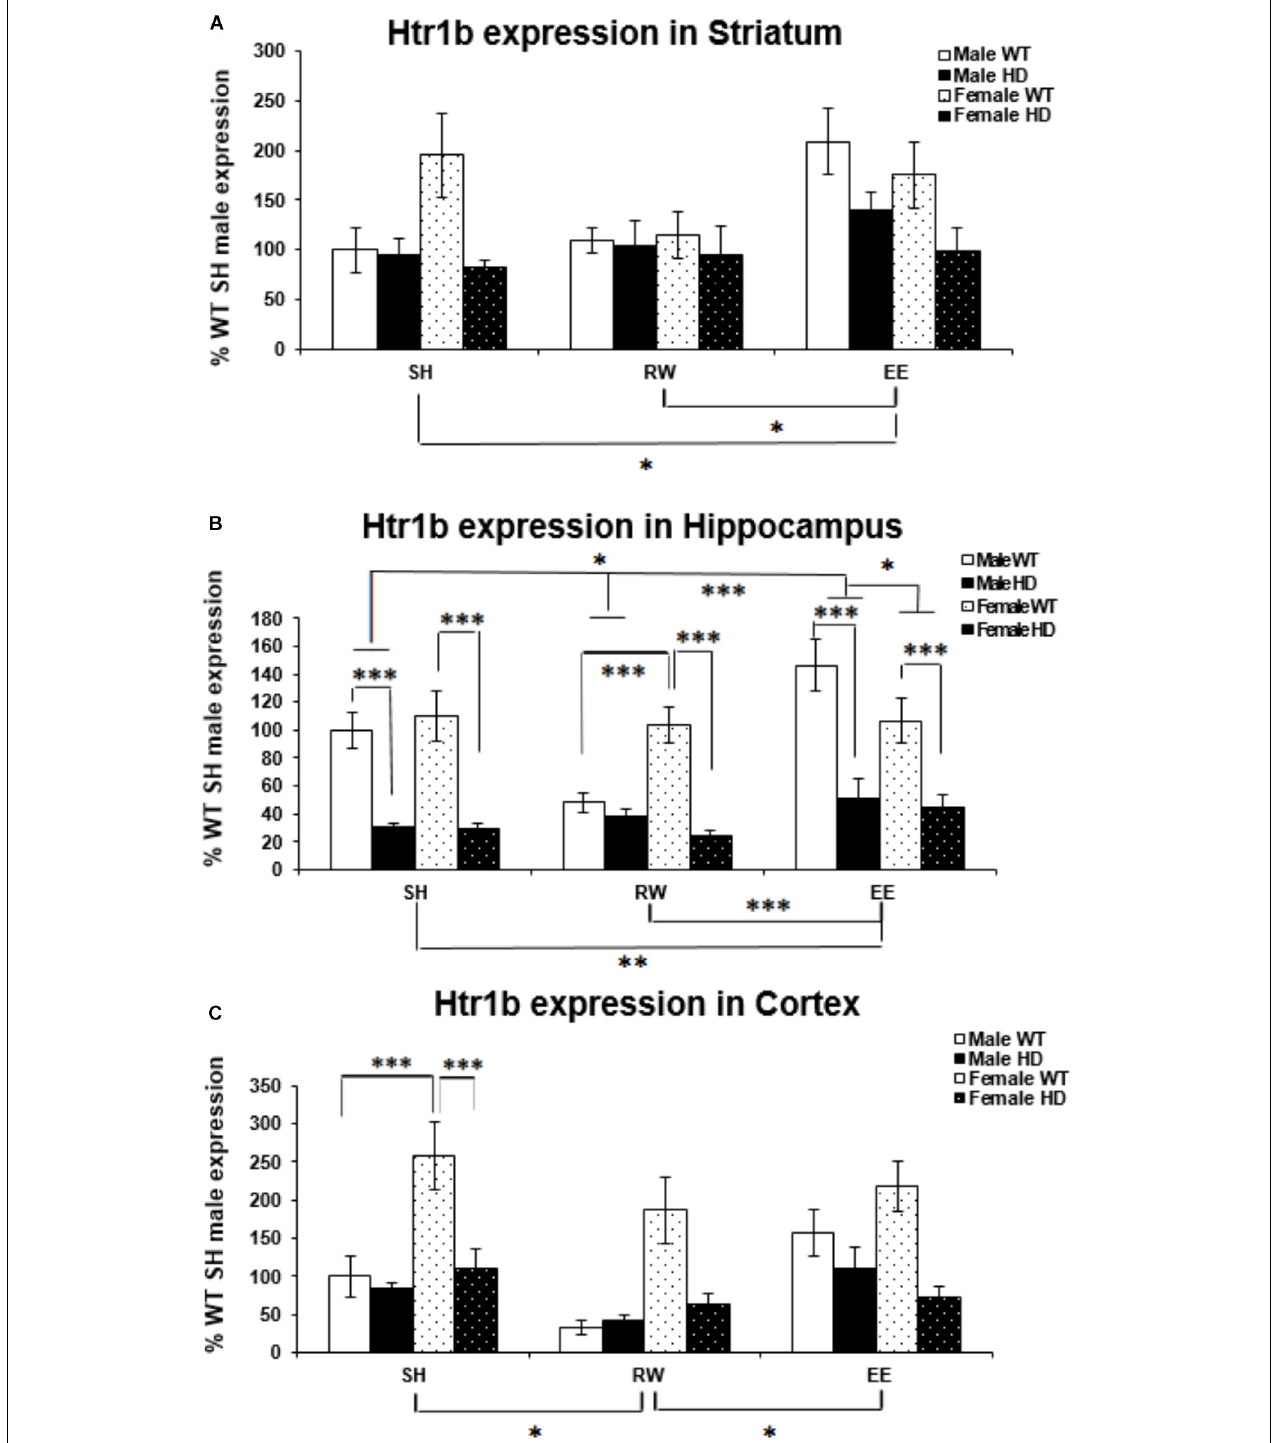
FIGURE 3 | Effects of genotype, environment and sex on Htr1b mRNA levels in 8-week-old WT and HD mice. (A) In Striatum, Htr1b expression was significantly affected by genotype in 8-week-old female mice ( p = 0.002). Housing environment significantly affected Htr1b mRNA levels ( p = 0.016). Post hoc testing showed that environmental enrichment ( p = 0.046), but not wheel running ( p = 0.860), significantly changed levels of Htr1b mRNA. There was no significant interaction between housing environment × sex ( p = 0.063). (B) In Hippocampus, Htr1b expression was decreased significantly in 8-week-old HD mice compared to